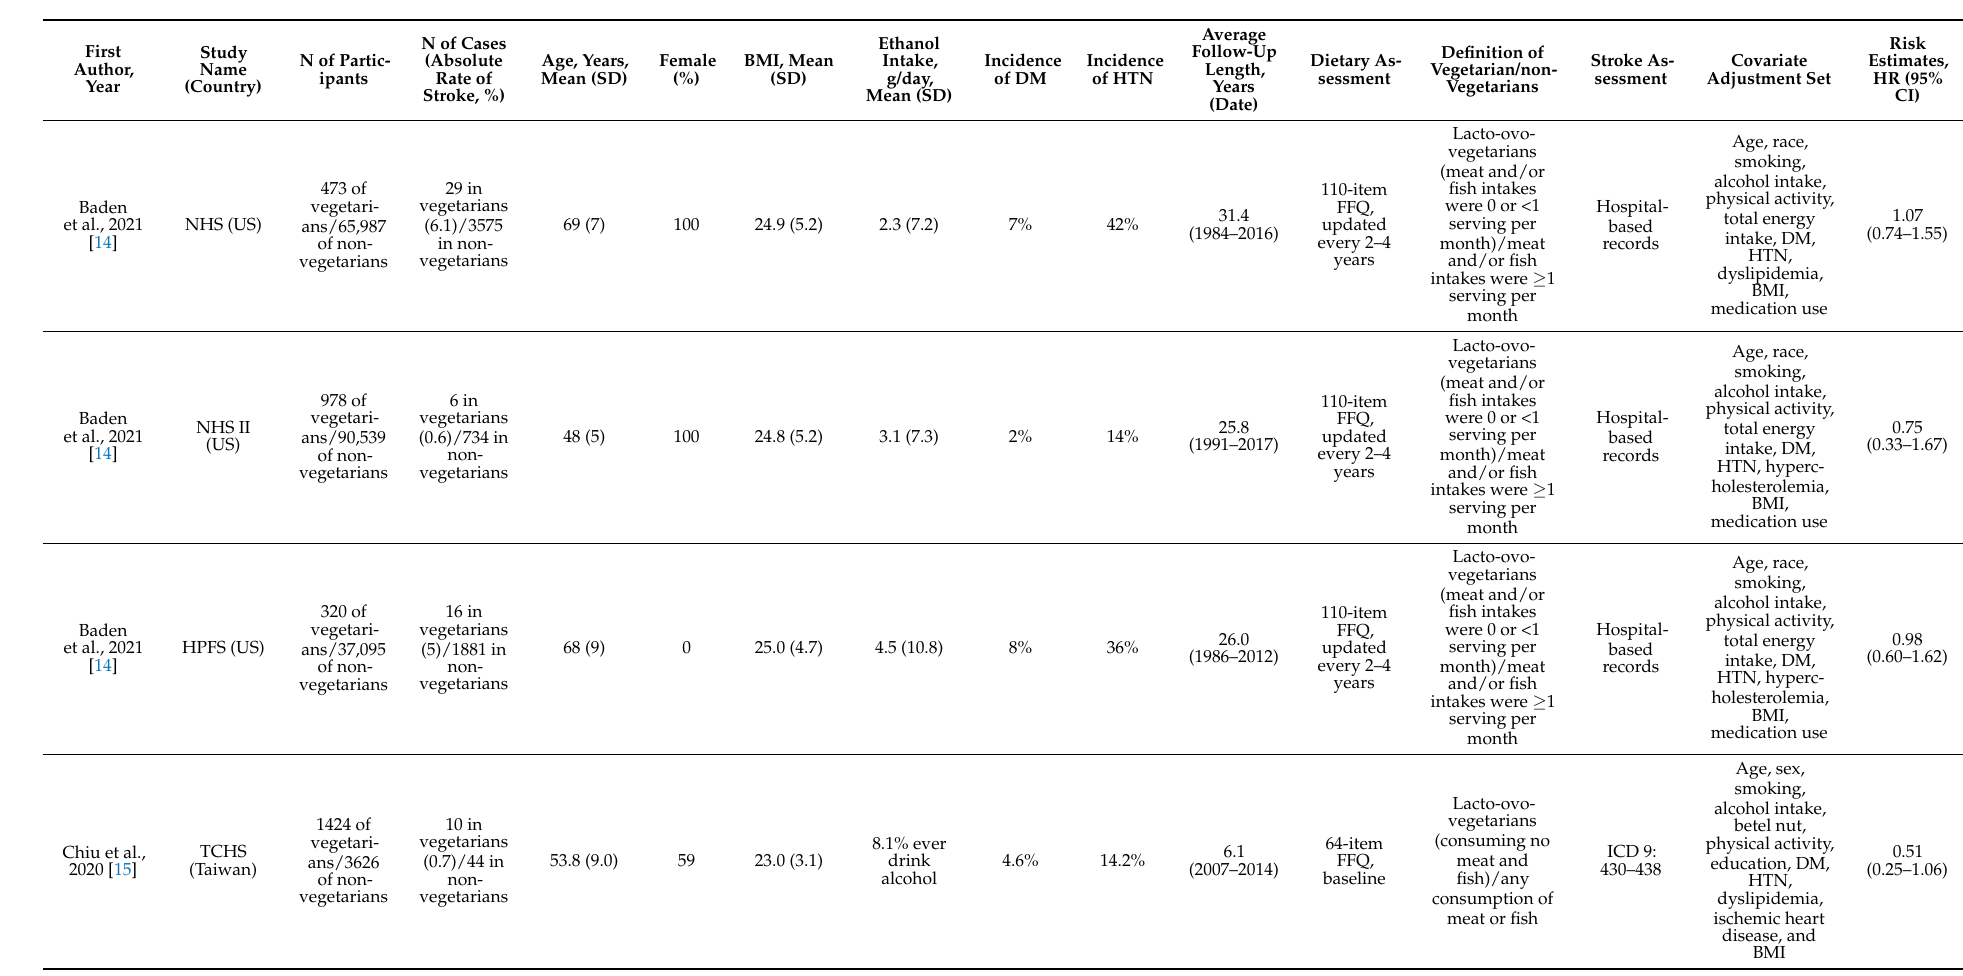
Table 1. Characteristics of the included